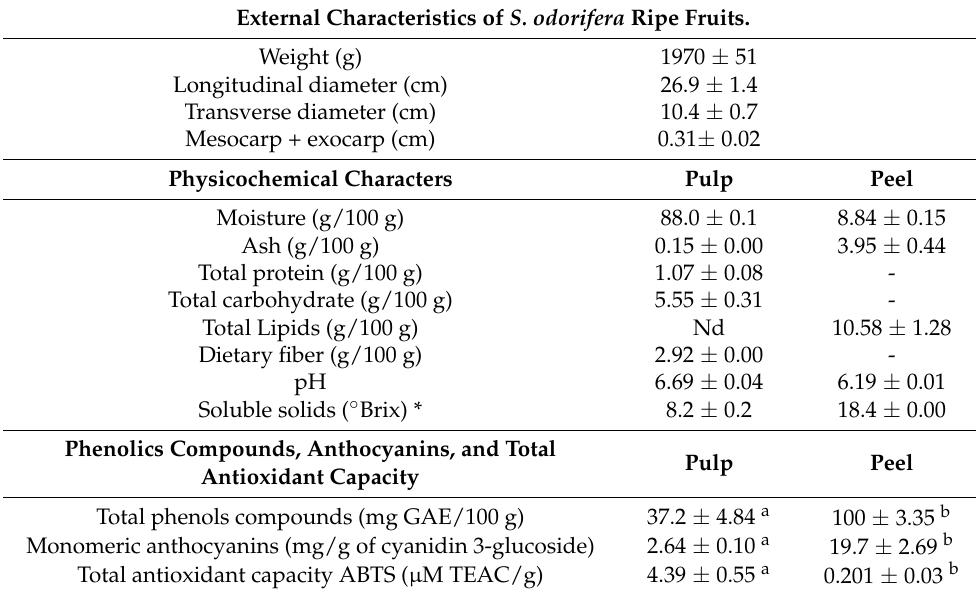
Table 2. Morphological characters and composition of ripe S. odorifera fruits, pulp and peel. External Characteristics of S. odorifera Ripe Fruits.